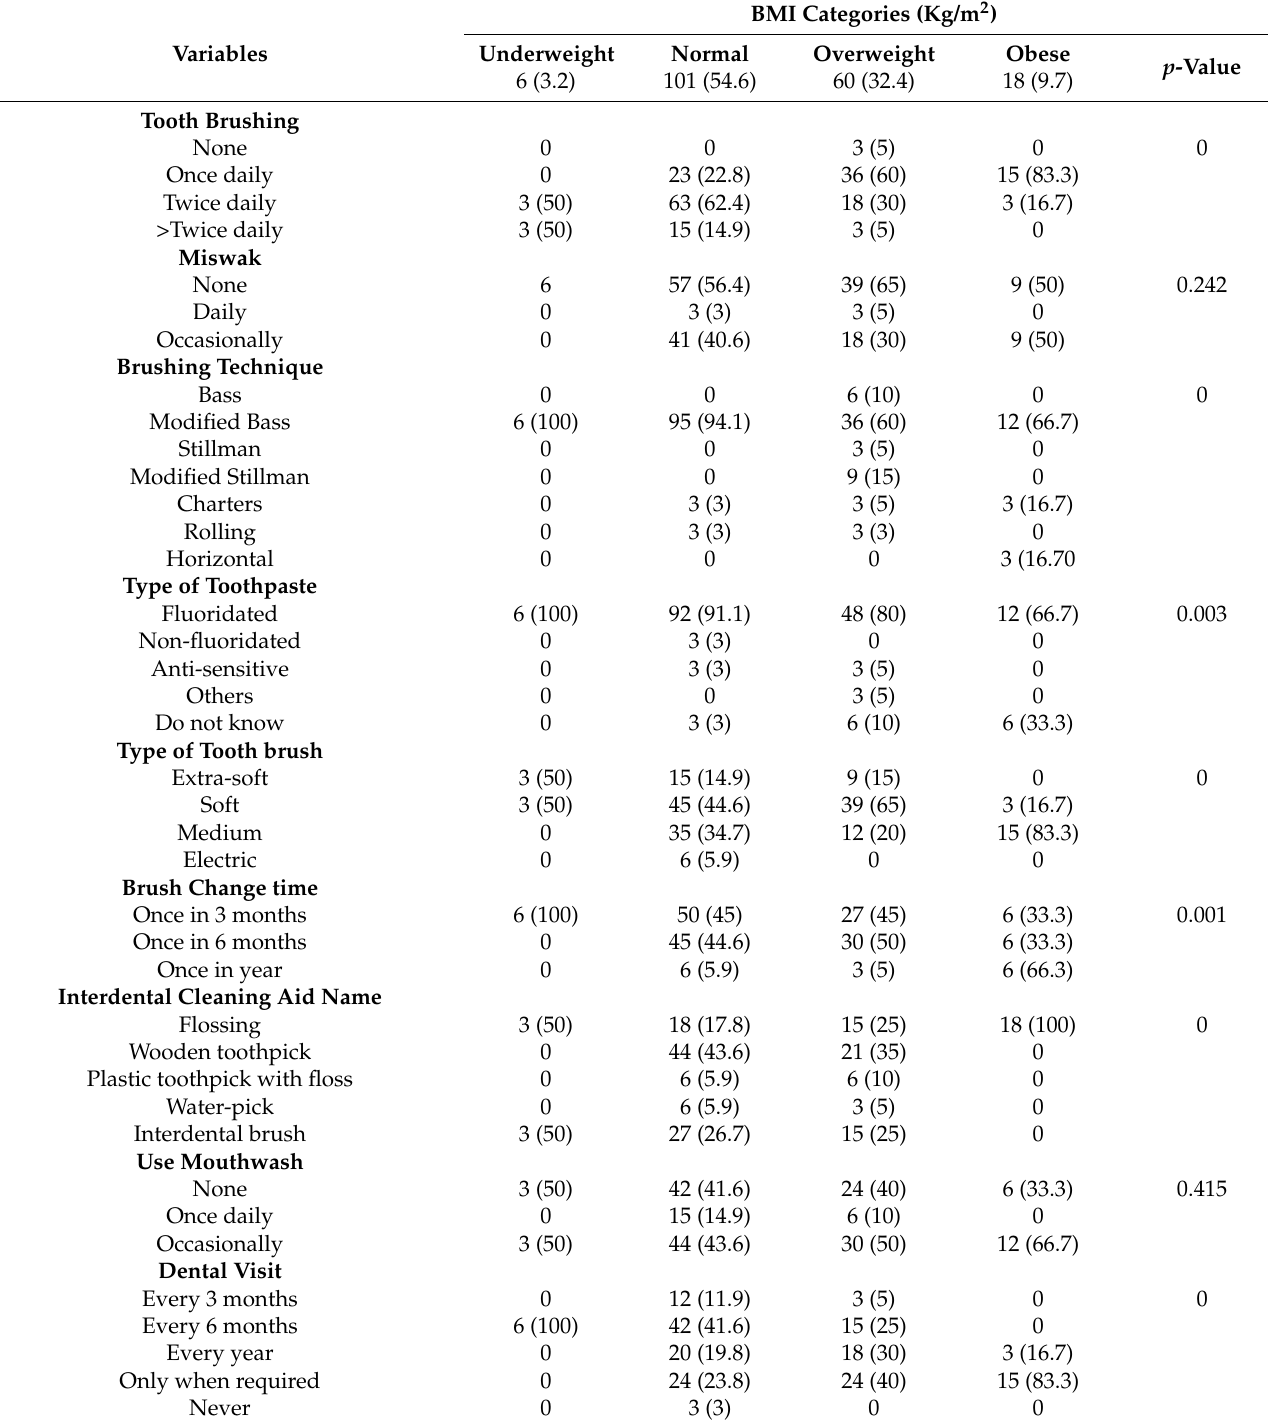
Table 3 explains the distribution of oral hygiene practices such as tooth brushing frequency per day, use of miswak, tooth-brushing technique, type of toothbrush, type of toothpaste, brush change time, use of interdental cleaning aids, use of mouthwash, and dental visits with respect to BMI categories. All variables showed significant ( p < 0.003) distribution except the use of miswak and mouthwash. Table 3. Distribution of Oral Hygiene Practices [ n (%)] among BMI